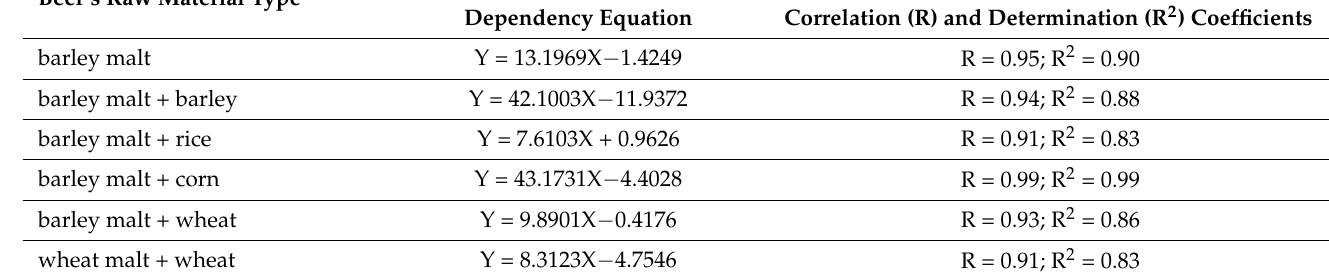
Table 10. The content of riboflavin (Y) on quercetin (X) characteristics dependence on the beer’s raw material